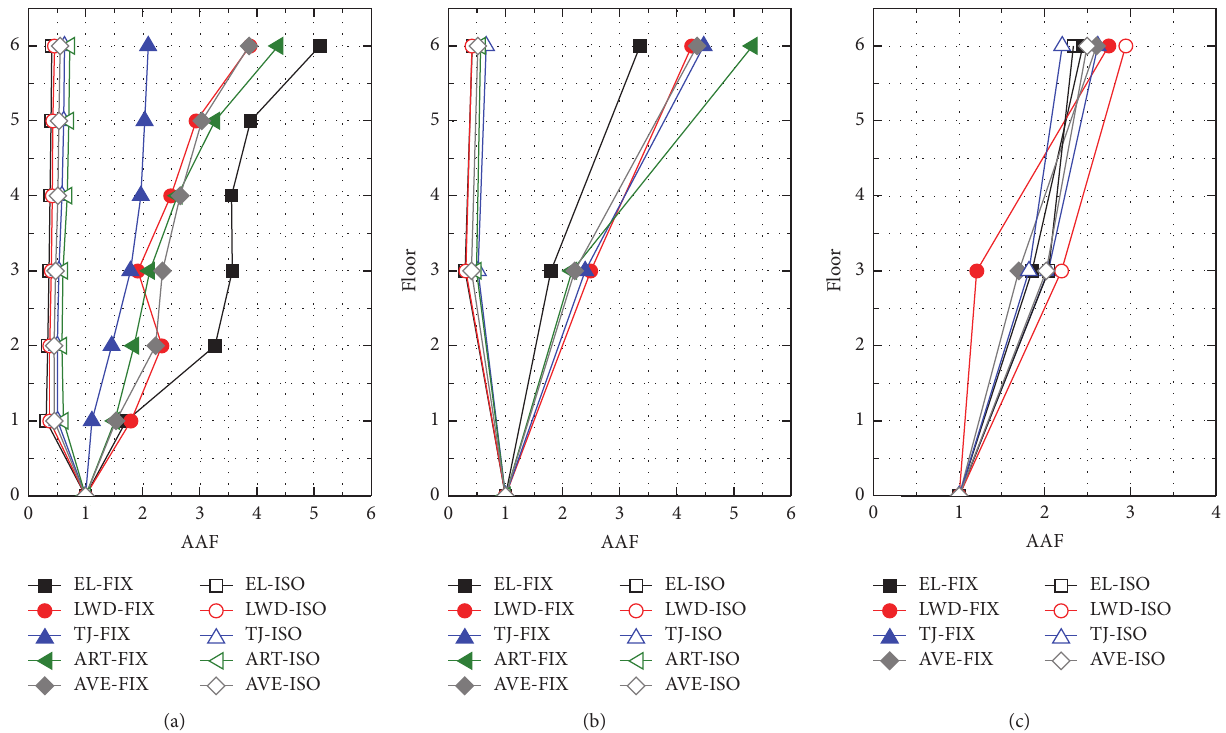
Figure 13: Comparisons of AAF for the isolated and fixed structures under minor earthquakes: (a) direction x ; (b) direction y ; and (c) direction z .